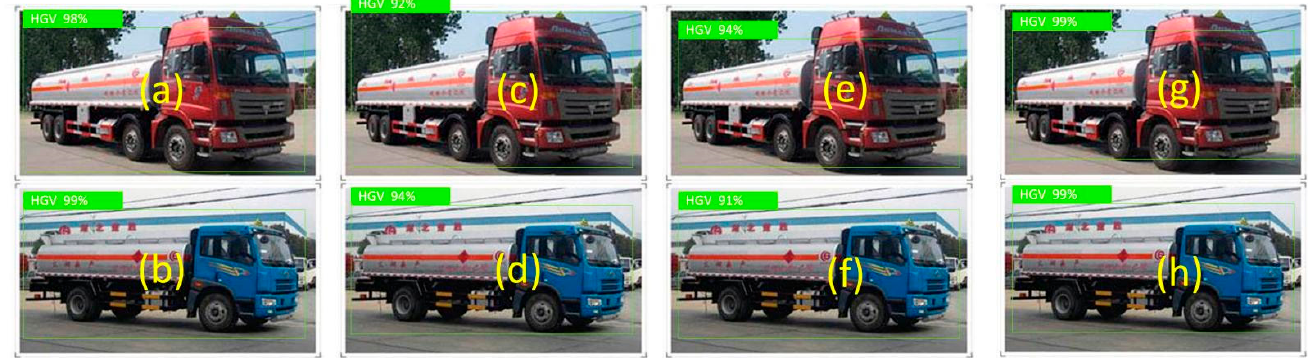
Figure 6. Detection effect of different methods on hazardous goods vehicles. ( a , b ) Proposed method. ( c , d ) Cascade R-CNN method. ( e , f ) CenterNet method. ( g , h ) EfficientDet-D7x method.